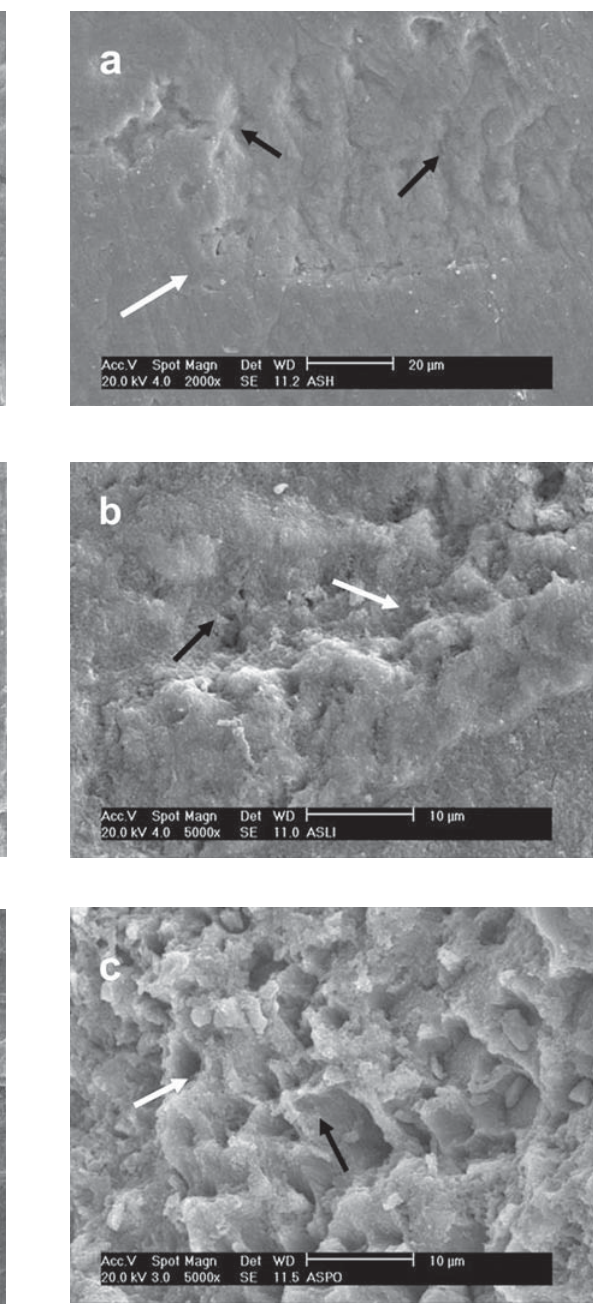
FIGURE 4- SEM micrograph of different enamel treated- groups following treatment with Clearfil SE primer. a – Prophylaxis: Small grooves (white arrow) and shallow depressions (black arrow) were seen in a predominantly flat surface; b – SiC paper: The white arrow shows smear layer remnants and the black arrow points to shallow depressions; c – Diamond bur: The CSE primer did not enhance the roughness provided by the diamond bur. Shallow depressions were observed (white arrows)